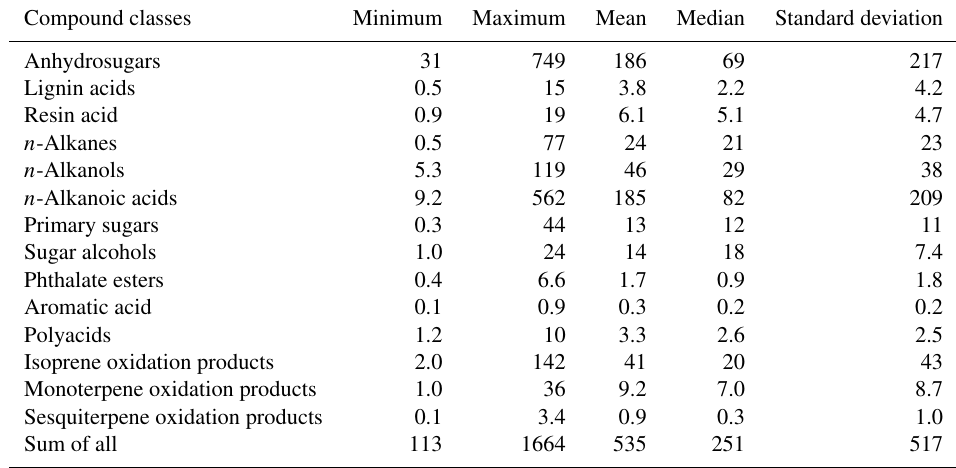
Table 1. Concentrations (ngm − 3 ) of organic tracer compound classes detected in PM 2 . 5 aerosols from central Alaska. Compound classes Minimum